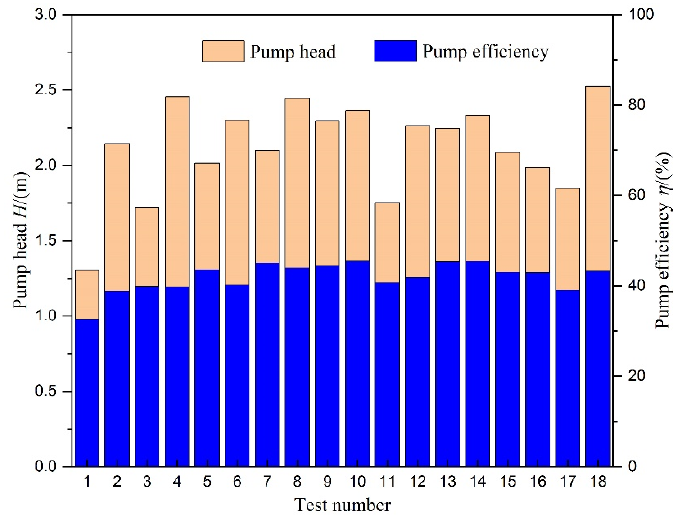
Figure 7. Column figure of orthogonal test results.